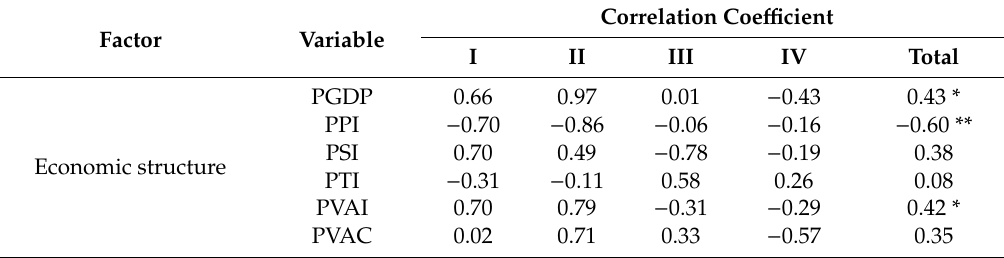
Table 2. Socioeconomic factors associated with the NAQI at the city level during 2015–2016. PCV, PPV, PLPV, PS, PT, PHT, POT means per unit area civil vehicle possession, passenger vehicle, large passenger vehicle, sedan, truck, heavy truck, and ordinary truck; PTEC, PCL, PCK, PDF, PH, PE denotes per unit area total energy consumption, coal, coke, diesel fuel, heat and electricity of industrial enterprises above a designated size; PFSCI and PFSCII shows per unit area floor space under construction and floor space under completion; PPI, PSI, PTI, PGDP, PVAI, and PVAC means the proportion of primary industry, secondary industry, tertiary industry, per capita gross domestic product, value-added by industry, and value-added by